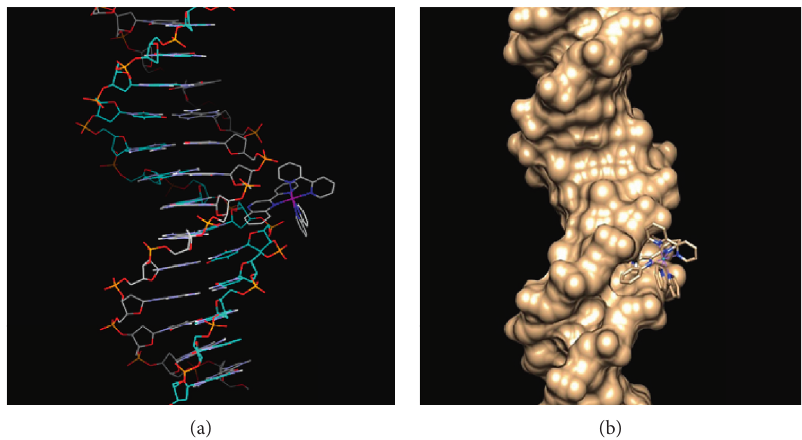
Figure 12: (a) Visualization of the interaction of 1 via 2, 2’-pq moiety to the specific region of the sequence of DNA (PDB: 5D2Q). (b) Interaction of complex 1 through 2, 2’-pq moiety with the hydrophobic DNA sequence (PDB: 5D2Q). Table 9: Molecular docking studies for 1 and 2 with the sequence (ACCGACGTCGGT) 2 (pdb code: 423D). Atoms that participate Distances